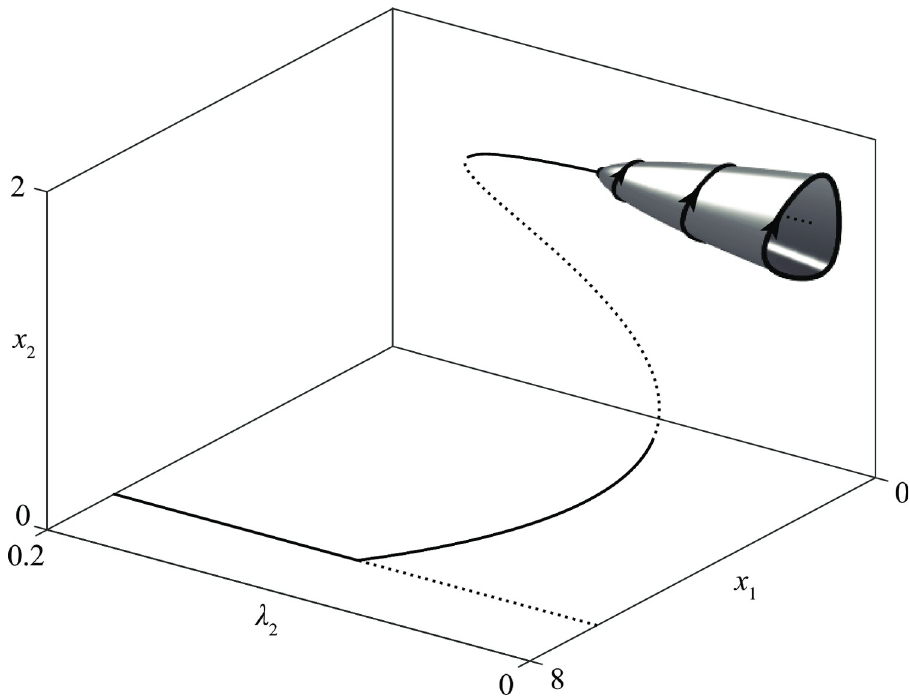
Fig 22. The case of mixed recruitment strategies. The influence of propensity to defend of an A group in the stalemate of a D – A conflict.